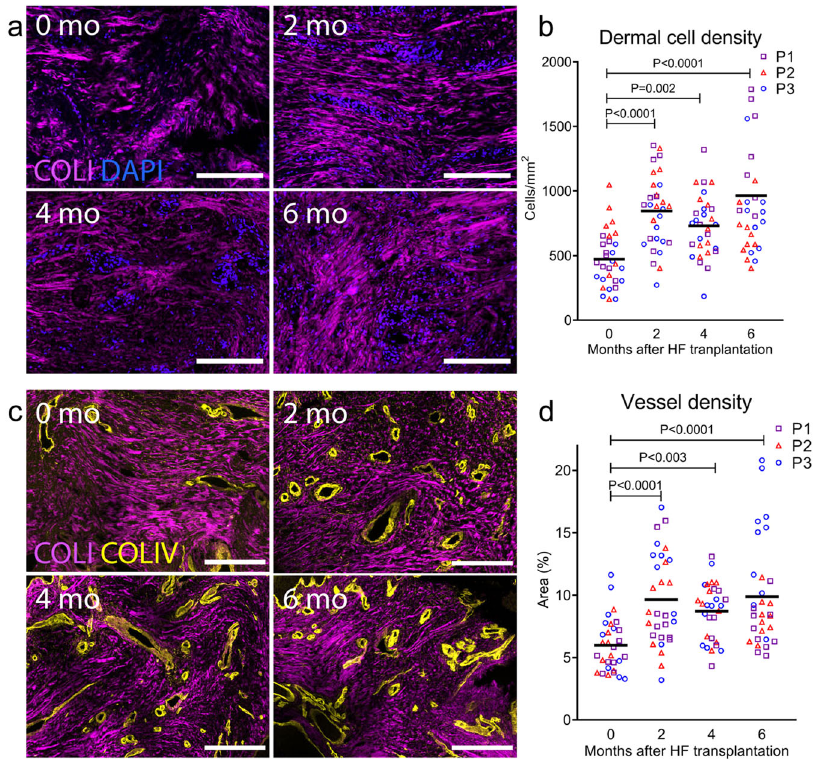
Fig. 3 Anagen hair follicles remodel the dermis of mature scars. a Representative immuno fl uorescence images of 10 μ m-thick sections of mature scars before (0 mo) and at 2, 4, and 6 months post-transplant of anagen hair follicles. We used DAPI nuclear counterstain to quantify cell nuclei within the dermis and second harmonic generation (SHG) imaging for collagen type I (COLI) fi bres. b Quanti fi cation of DAPI-stained nuclei revealed an increase in the dermal cell density at 2, 4, and 6 months after hair follicle (HF) transplantation ( n = 20, N = 3). c Immuno fl uorescence imaging of scar sections for collagen type IV (COLIV) present in the basement membrane of blood vessels combined with SHG imaging. d We quanti fi ed the area (%) covered by COLIV staining and found that the dermis of scars contains higher vessel density after hair follicle transplantation ( n = 20, N = 3). Reported P values are based on two ‑ way ANOVA tests, and the horizontal lines show grand means. Representative images from one patient, scale bars = 200